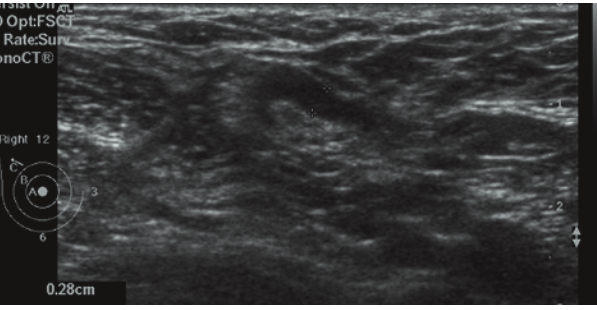
Fig. 3. The follow-up ultrasound 4 weeks later documents that the cortical thickness of the lymph node has returned to the upper limits of normal (2.8